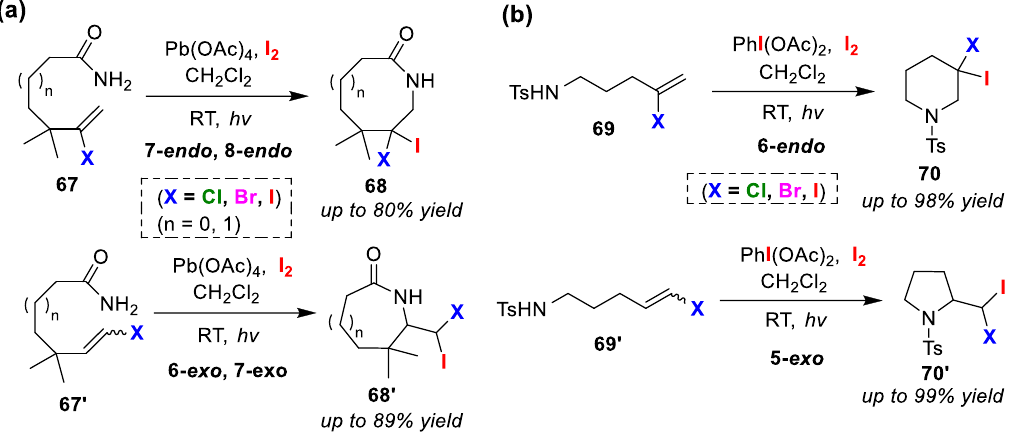
Figure 33. Endo / exo selective ( a ) halolactamization reactions of halovinyl amides ( 67 and 67 (cid:48) ) and Figure 33. Endo/exo selective (a) halolactamization reactions of halovinyl amides ( 67 and 6 7′ ) and (b) ( b ) halo-amino-cyclization reactions of halovinyl sulfonamides ( 69 and 69 (cid:48) ) via intramolecular halo-amino-cyclization reactions of halovinyl sulfonamides ( 69 and 6 9′ ) via intramolecular halogen halogen control.